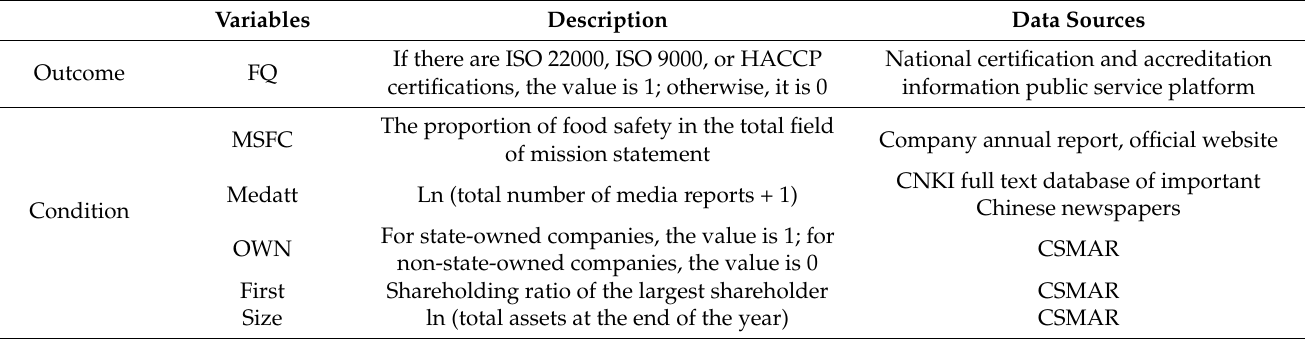
Table 1. Description and source of outcome and conditional